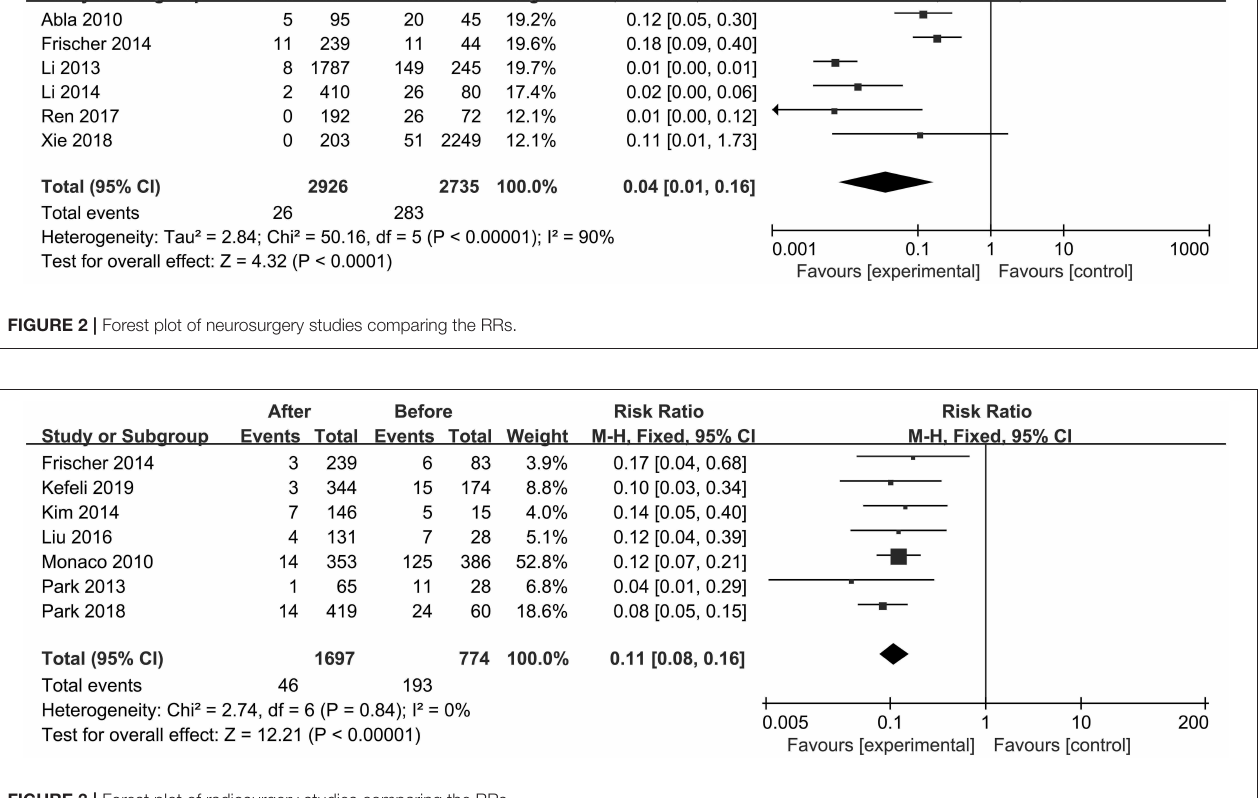
FIGURE 3 | Forest plot of radiosurgery studies comparing the